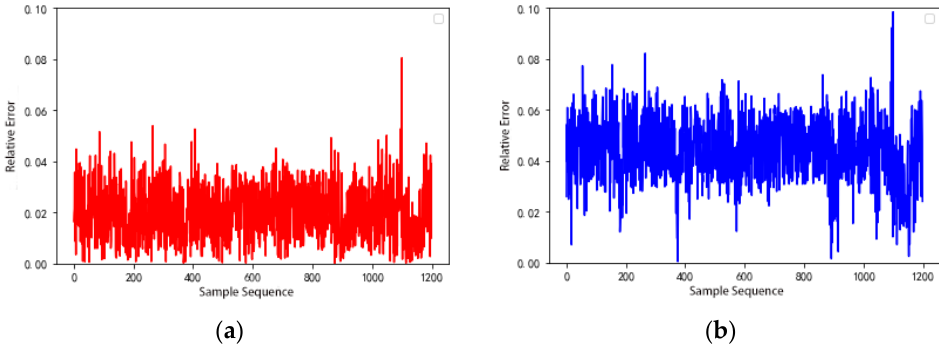
Figure 6. Comparison chart of training-data fitting effect.